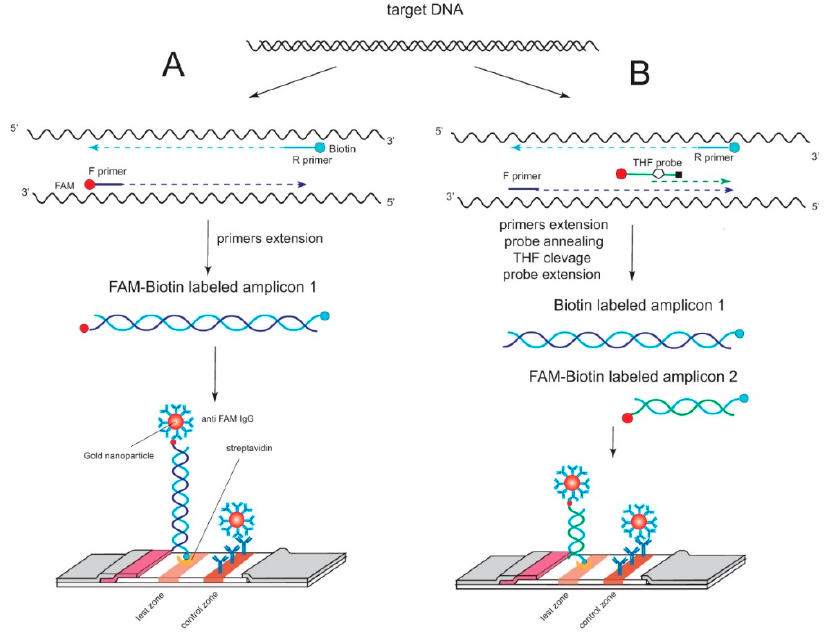
Figure 1. Scheme of RPA-LFT with the generation of labeled amplicons and their detection, based on ( A ) both labeled primers, ( B ) labeled THF probe, and labeled reverse primer.